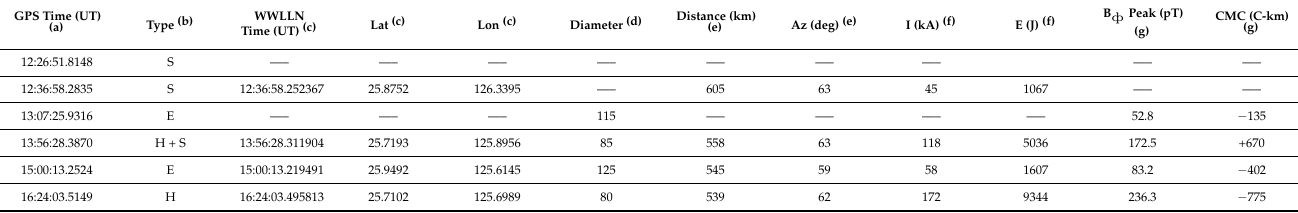
Table 1. The 2020 Taiwan campaign observed TLEs (two sprites, two elves, and two halos) on June 22.